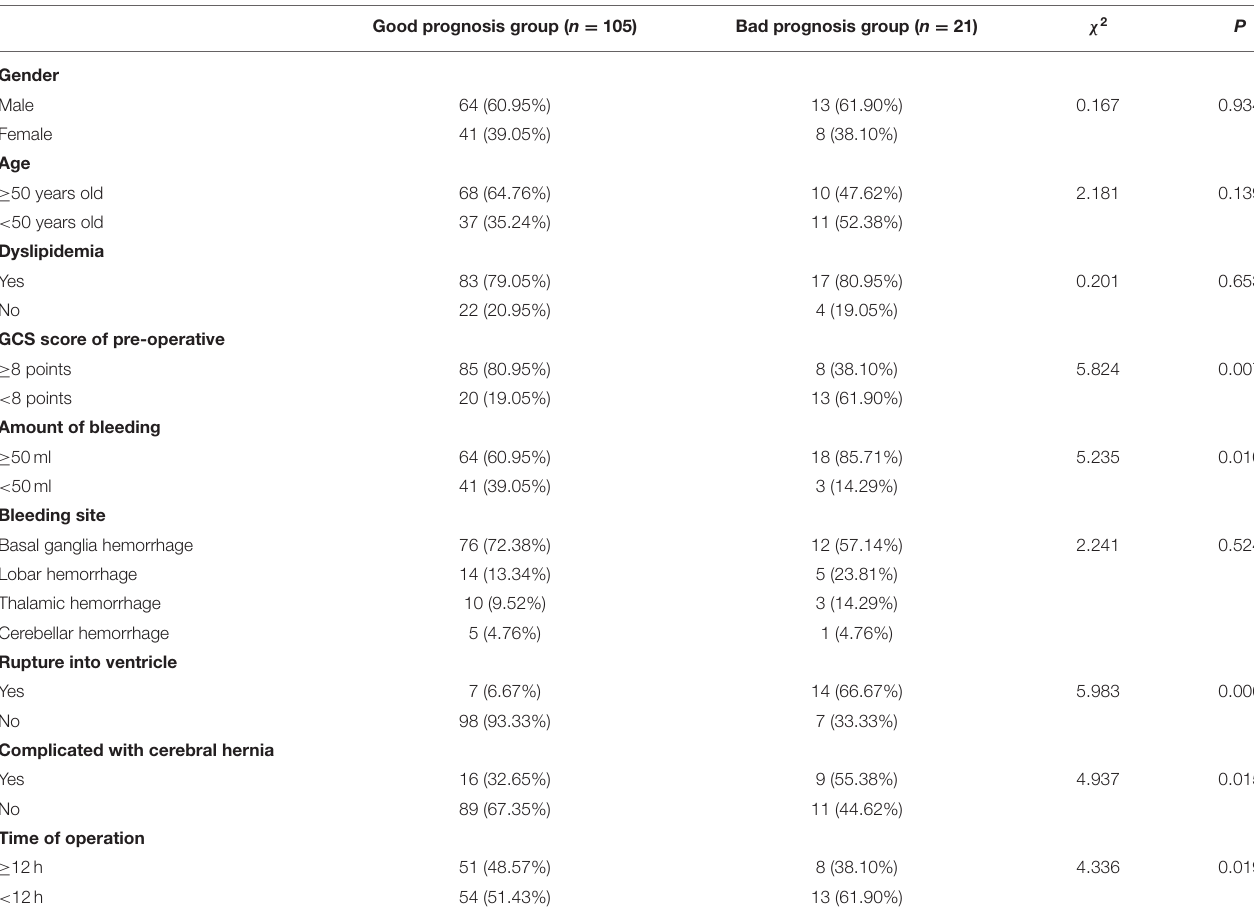
TABLE 4 | Single-factor analysis of influencing prognosis of patients with hypertensive intracerebral hemorrhage (HICH) ( n , %). Good prognosis group ( n = 105) Bad prognosis group ( n =